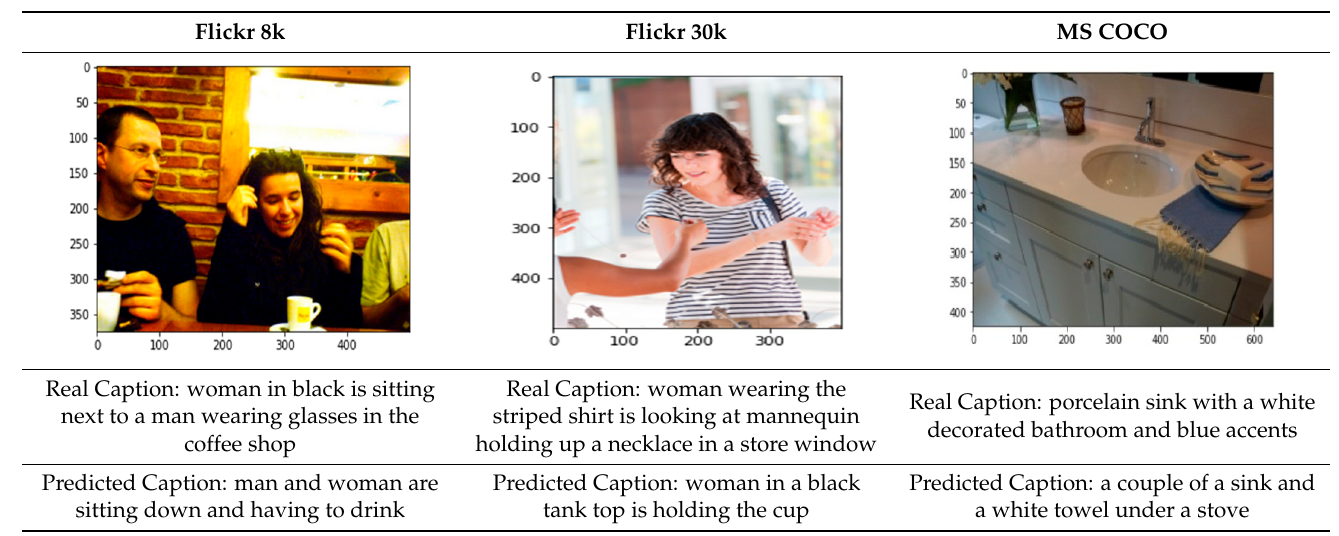
Table 4. A comparison of captions generated using the attention model on Flickr 8k, Flickr 30k and Microsoft Common Objects in Context (MS COCO) datasets.